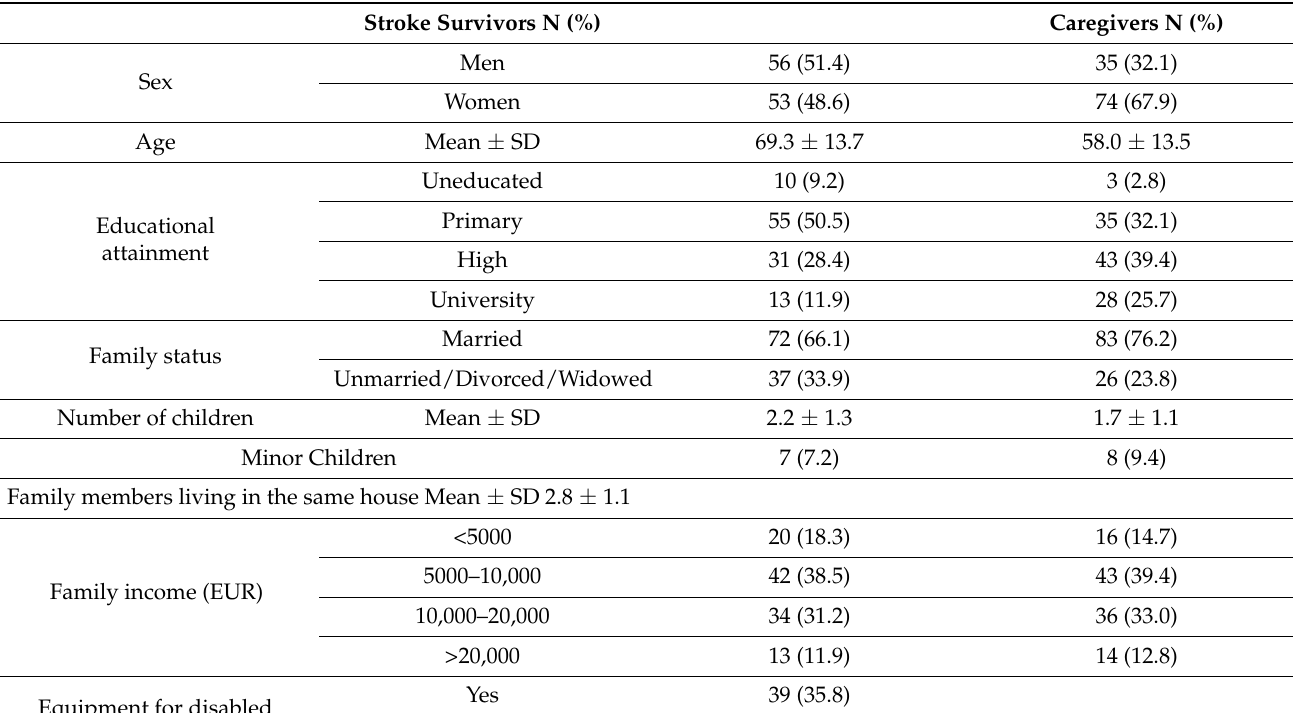
Table 1. Demographic characteristics of the patient and caregiver sample (N =